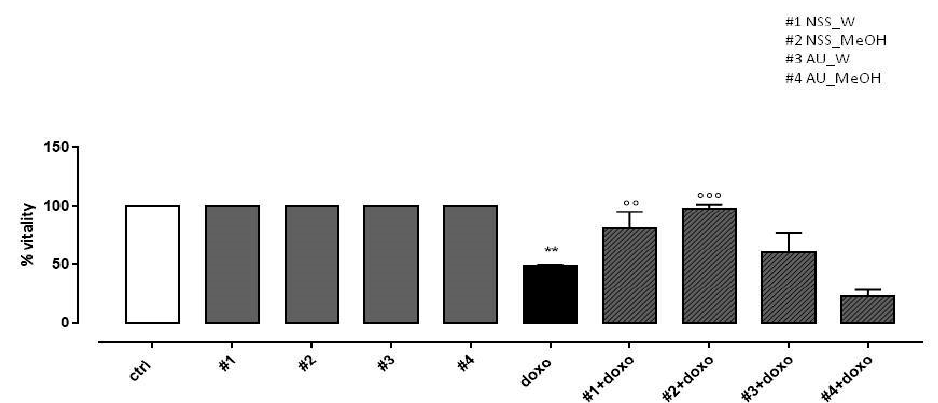
Figure 2. E ff ects of NSS and AU extracts on H9c2 cell viability. NSS and AU extracts (50 µ g / mL) Figure 2. Effects of NSS and AU extracts on H9c2 cell viability . NSS and AU extracts (50 μ g/mL) were